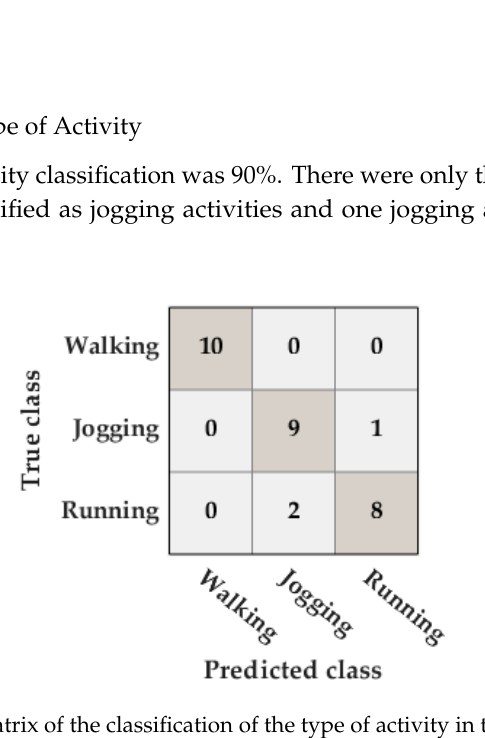
Figure 9. Confusion matrix of the classification of the type of activity in the Unicauca dataset.